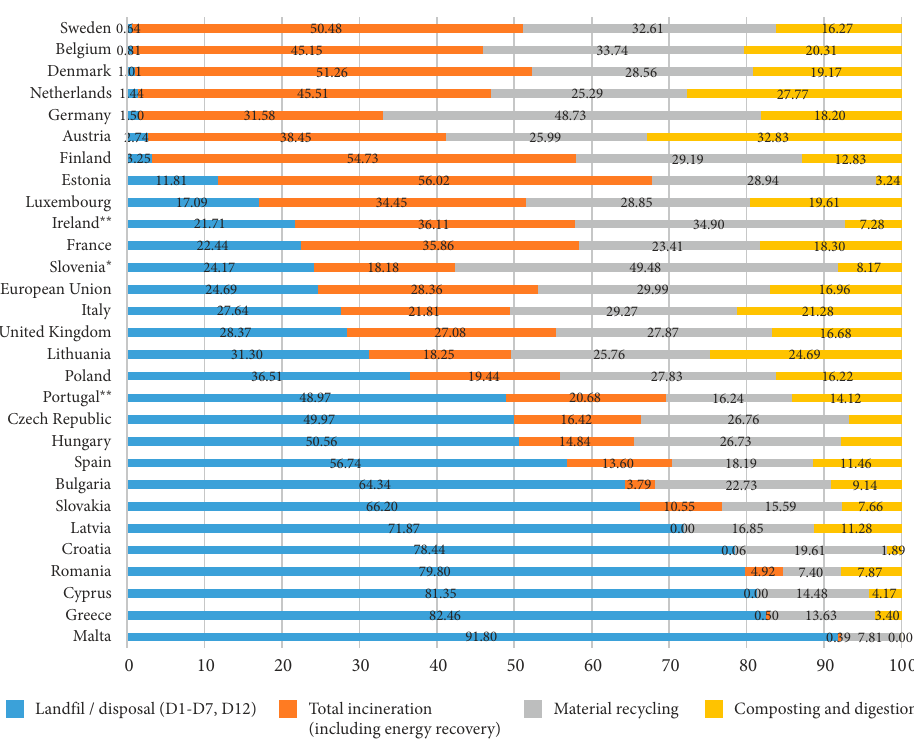
Figure 3. Structure of municipal waste by type of treatment, in UE in 2016 (source: Own elaboration based on Eurostat,